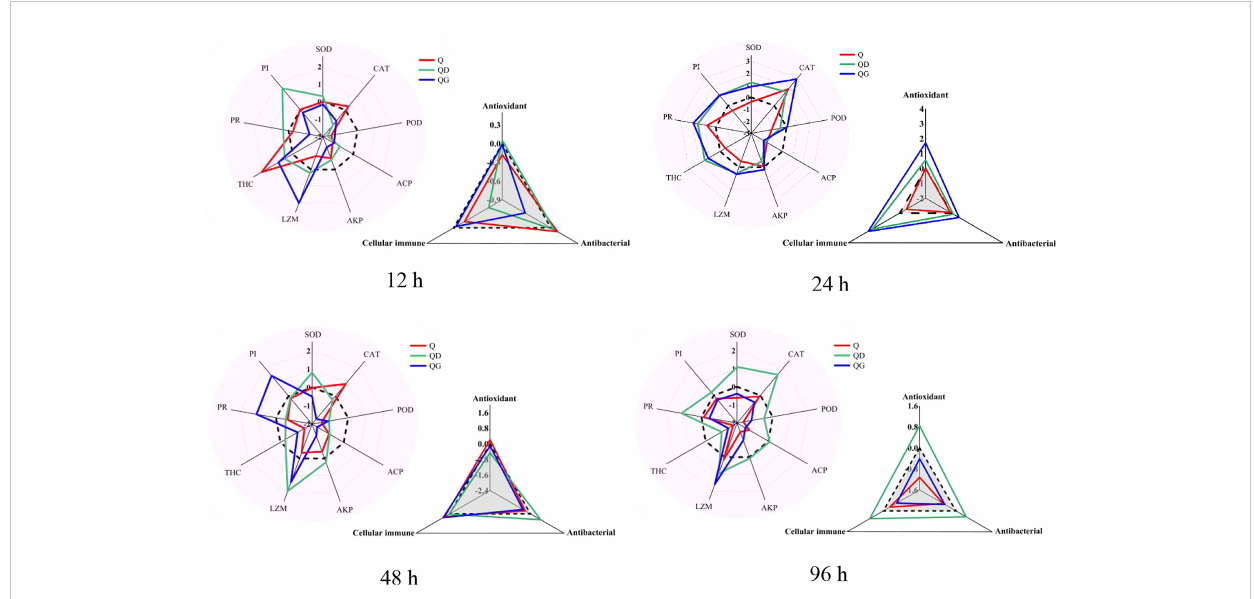
FIGURE 3 Star plots and the integrated biomarker response ( IBR ) of immune-related biomarkers in the adult Tegillarca granosa exposed to hypoxia and sul fi de. Zero, Q, QD, QG, stand for the control level, hypoxia group, hypoxia and mild-sul fi de group, hypoxia and high-sul fi de group; THC, Total count of haemocytes; PR, phagocytic rate; PI, phagocytic index; SOD, superoxide dismutases; CAT, catalase; POD, peroxidase; ACP, acid phosphatase; AKP, alkaline phosphatase; LZM,